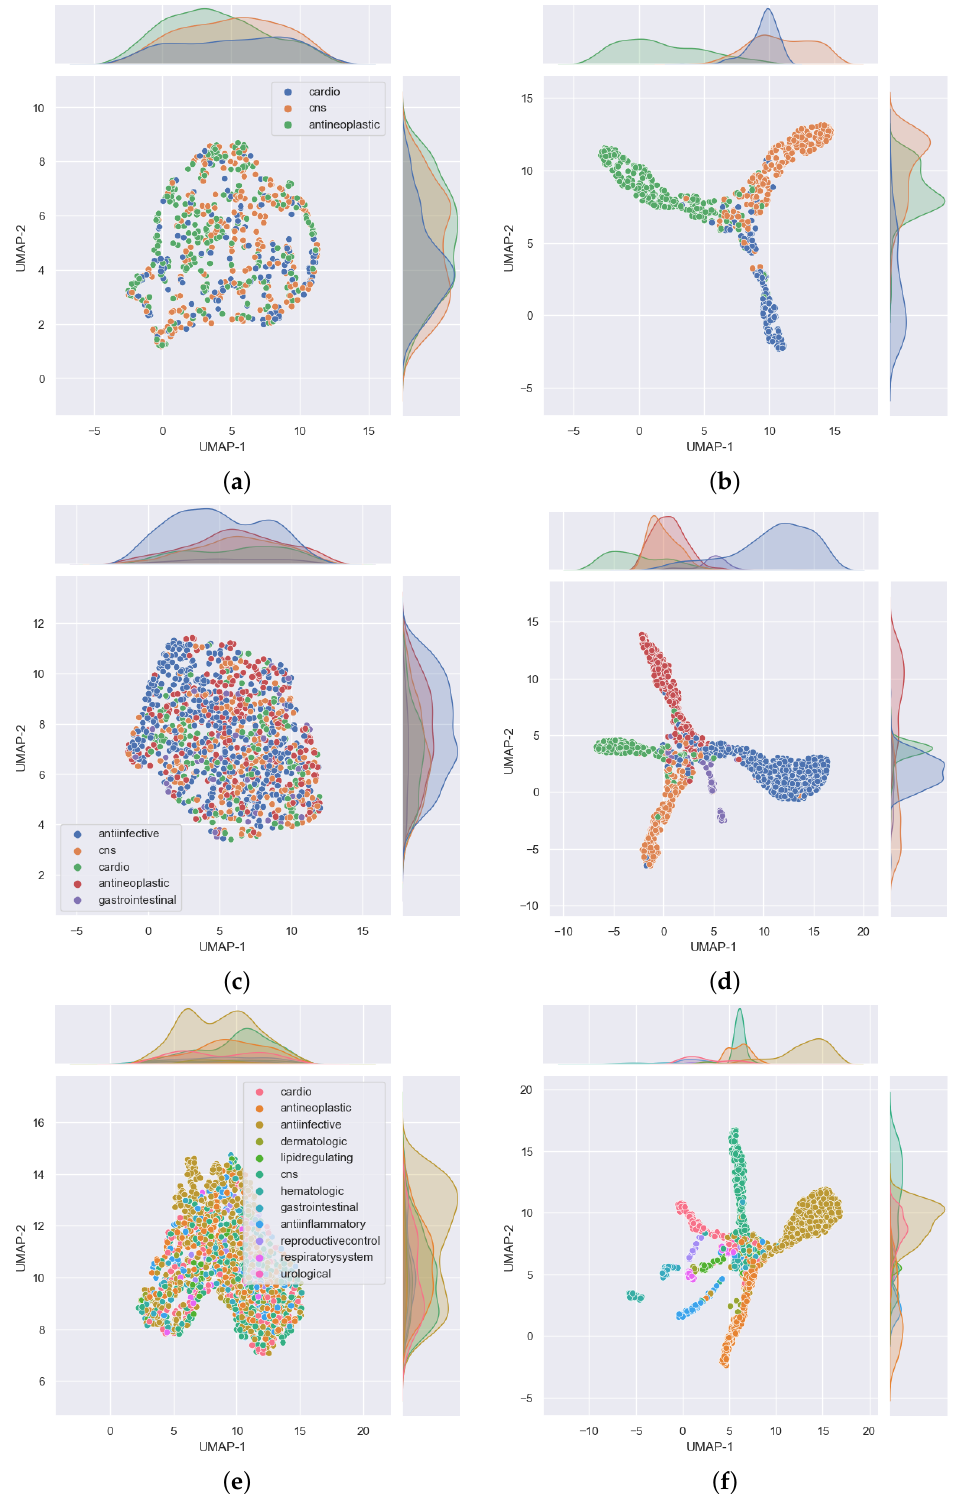
Figure 4. Distribution of the fifth fold cross validation data used in the 3, 5, and 12 single label classification task subgroups shown on ( a , c , e ), respectively. On the other hand, ( b , d , f ) show the distribution of the same data after passing them through our trained GCN models for 3-, 5-, and 12-task subgroups, respectively. The latter group of subfigures show that drugs belonging to one MeSH class appear closer to each other in the 2D UMAP space (which is not the case in the earlier group of subfigures). This shows that the models are able to classify the drugs into the 3, 5, and 12 MeSH classes as intended. These subfigures were plotted using Seaborn [26] after we reduced the dimensions of the drugs to two using UMAP